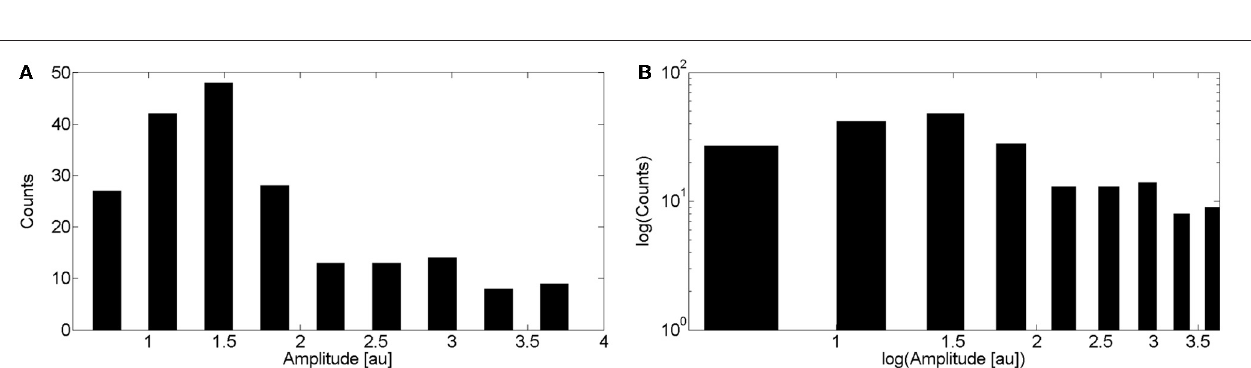
FIGURE 4 | Transition between Ca 2 + -binding limited and IP 3 -binding limited cases in the event size distribution of the inter-cluster model. (A) Similar to Figure 3B but using a mean number of IP 3 -bound IP 3 R’s equal to 4. (B) Similar to (A) but using a mean number of IP 3 -bound IP 3 R’s equal to 20.